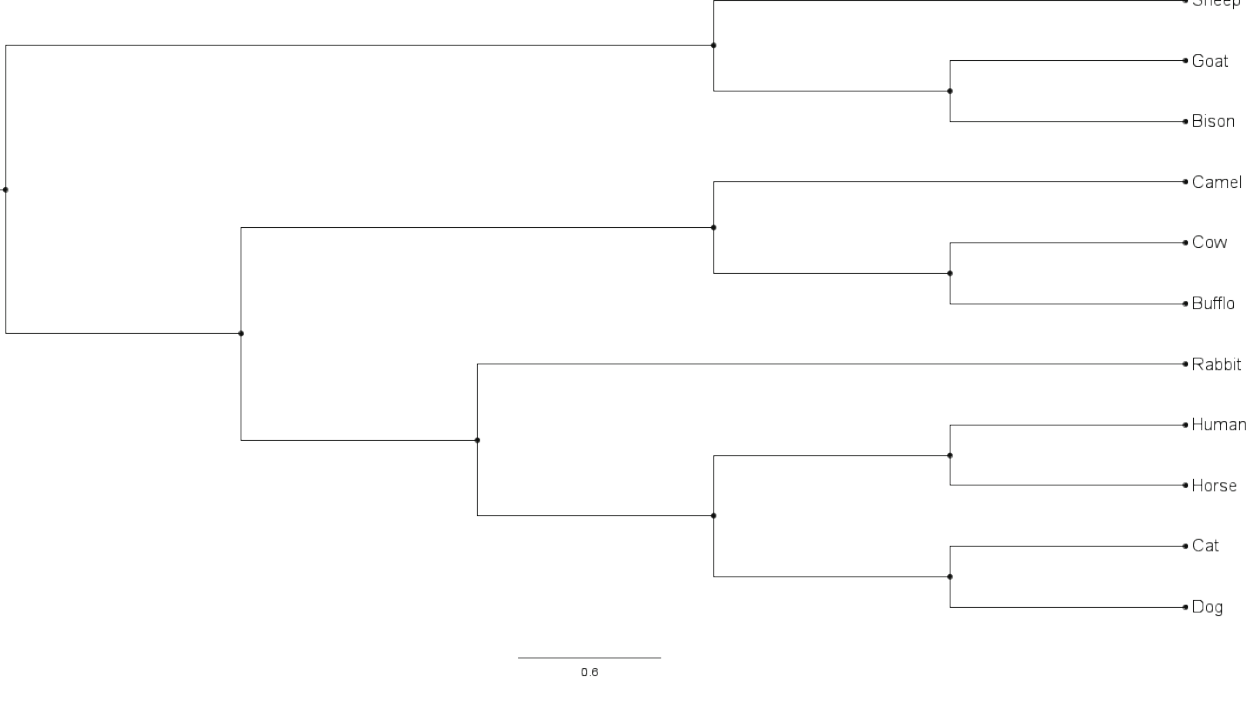
Figure 2. Phylogenetic relationship of IL-32 gene in different Table 3. Coding sequences similarity analysis and values of pair wise comparison of interleukin-32 gene among different species Goat Sheep Bison Camel Buffalo